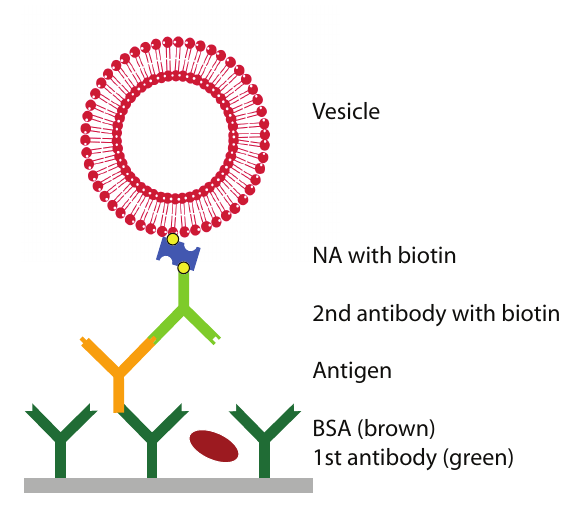
Figure 2. QCM-D curve showing frequency and dissipation changes during the adsorp- tion steps. i) Primary antibody, ii) BSA (part of it is removed upon rinsing), iii) antigen (400 ng/ml), iv) secondary antibody, v) neutravidin, vi) vesicles. The spikes (marked with dotted arrows) are an artefact upon injection/rinsing.